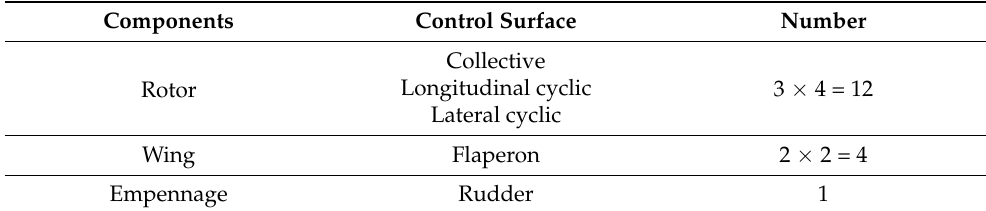
Table 3. Forms and numbers of control inputs.